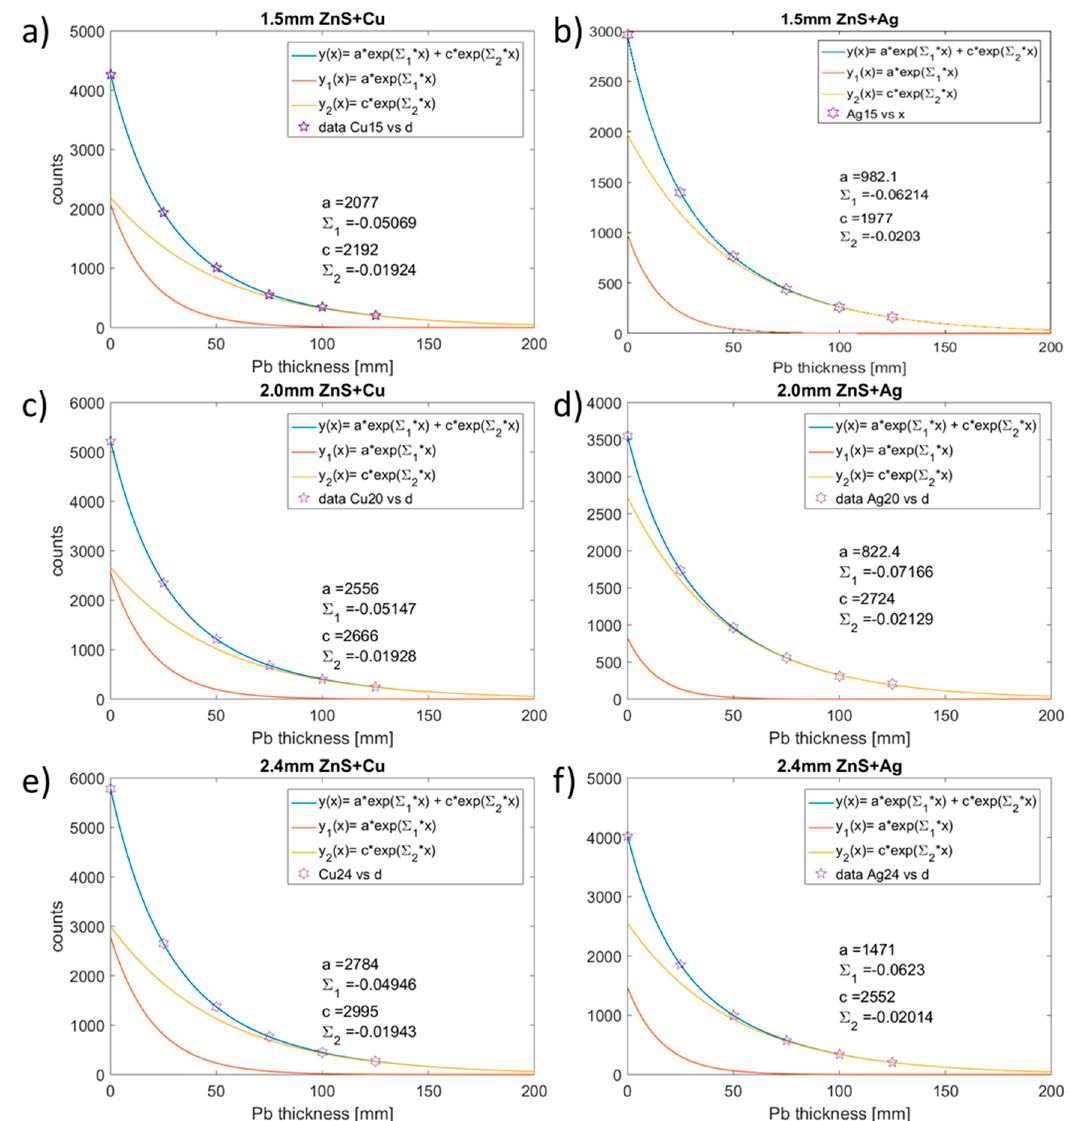
Figure 4. Function fitted to the measured beam intensities for different lead thicknesses (d Pb ), (blue curves) together with plotted functions evaluated for the neutron (yelow curves) and gamma (red curves) beam components for PP/ZnS:Cu (( a , c , e ) and PP/ZnS:Ag ( b , d , f )). The yellow and red curves represent the exponent functions y 1 (Equation (2)) and y 2 (Equation (3), respectively, which are the summands of the function y (Equation (1)).